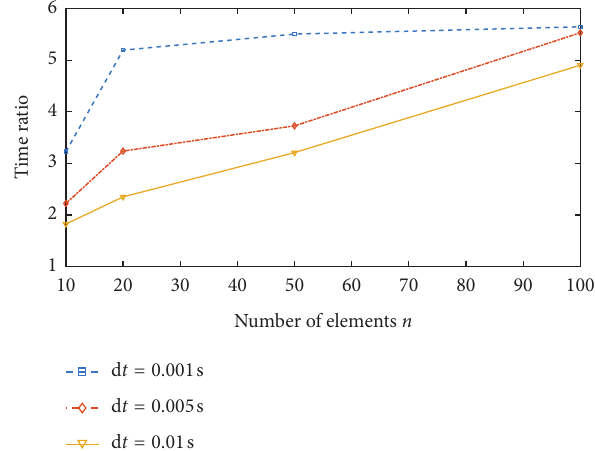
Figure 10: The time ratio between the stiffness method over the flexibility method.